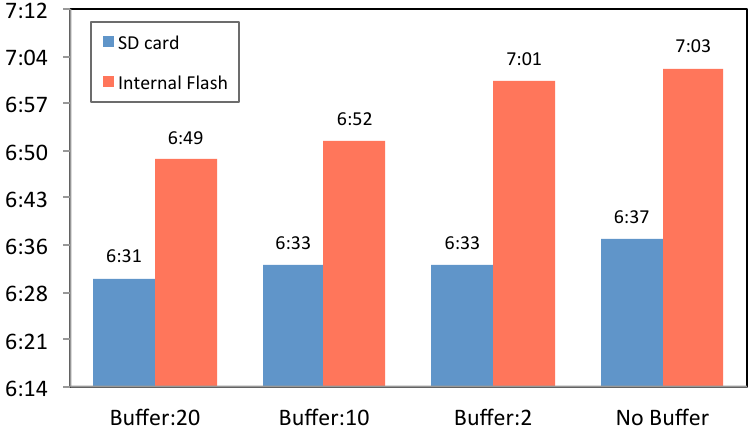
Figure 8. Battery discharge duration from 100% to 10%, with different buffer sizes and different storage locations, i.e. , internal flash memory or SD